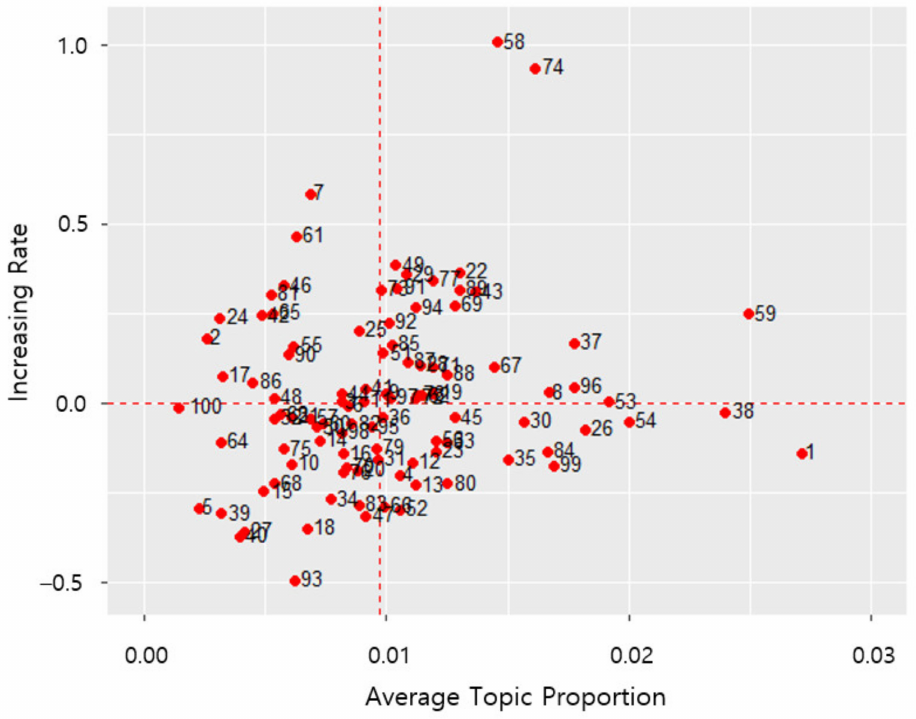
Figure 3. Placement of topics in the quadrant.